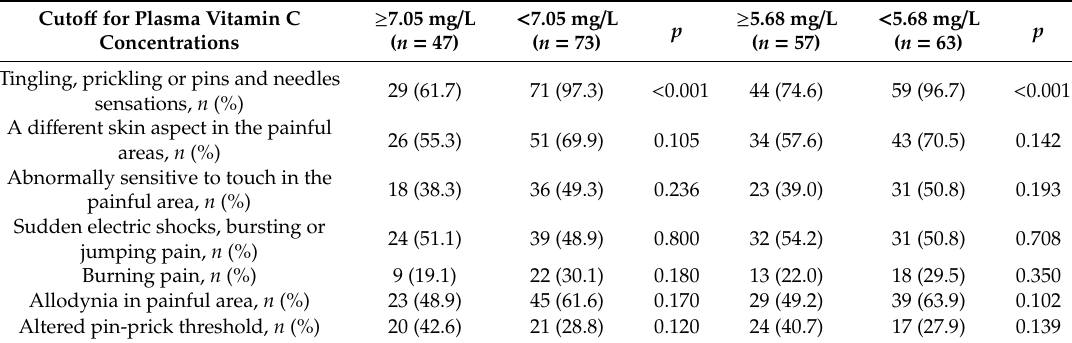
Table 3. The proportions of positive items in the LANSS questionnaire among patients with vitamin C concentrations ≥ the cutoff value vs. < the cutoff value.